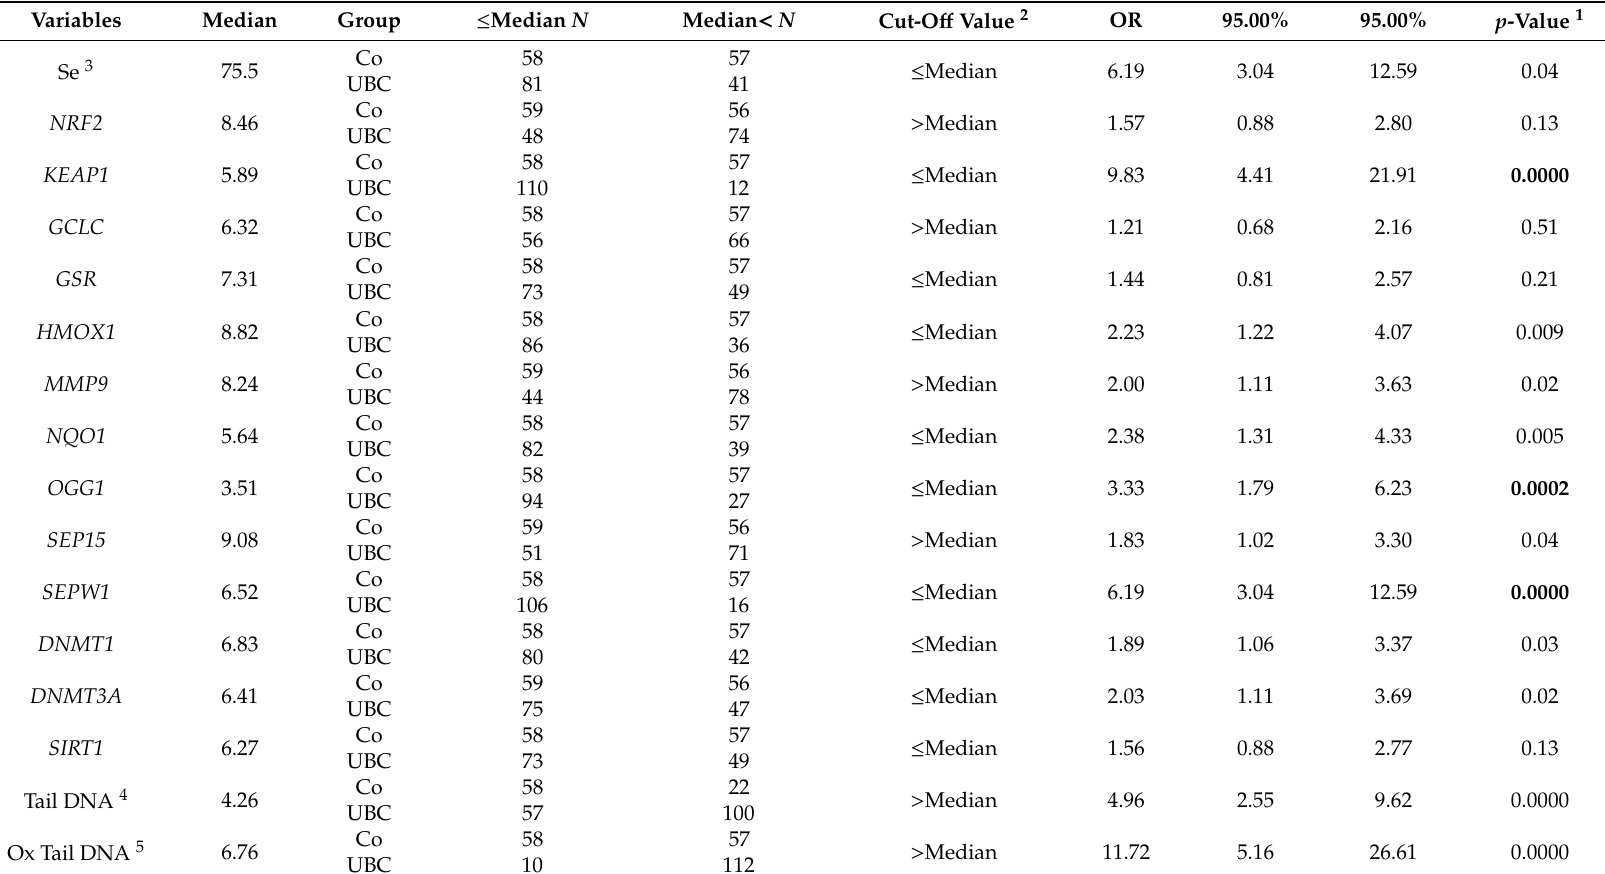
Table 3. Odds ratio multivariate analyses for redox status indices in the urinary bladder cancer